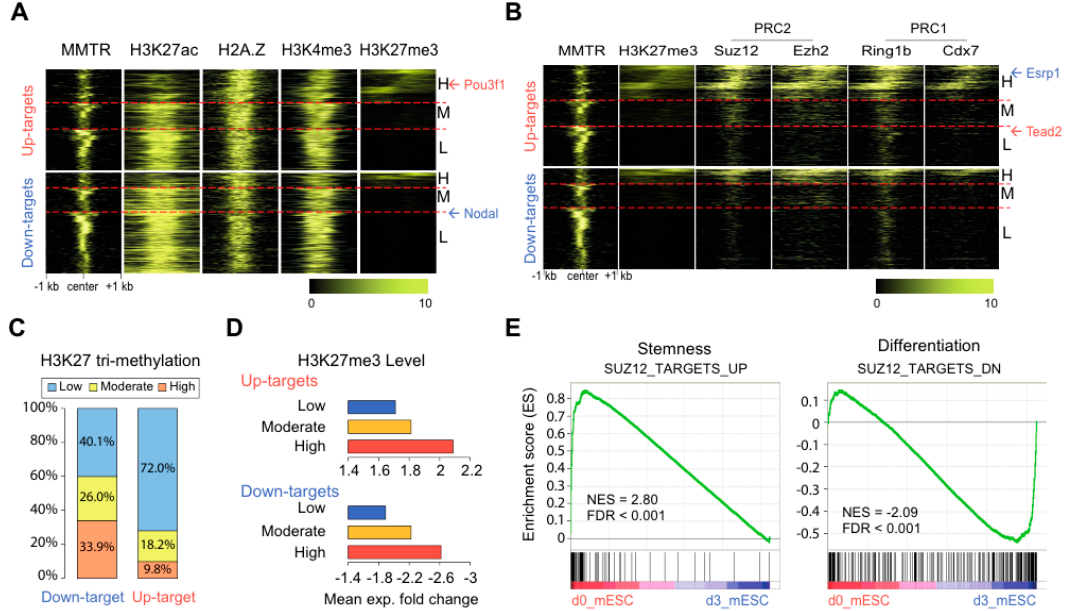
Figure 4. MMTR/Dmap1 co-localizes with PRC complex proteins at the promoters of the MMTR/Dmap1 up- and down-targets. ( A ) Heat maps showing histone modifications and H2A.Z at the MMTR/Dmap1 binding regions of up- and down-target promoters in undifferentiated mESCs. We sorted heat maps by the propensity of H3K27me3 modification (high, medium, and low levels). ( B ) Heat maps showing binding patterns of MMTR/Dmap1 and PRC proteins at the target promoters. The color bars indicate binding strength. ( C ) The proportion of H3K27me3 modification strengths in the MMTR/Dmap1 up- and down-targets. ( D ) The mean expression fold changes of both up- and down-targets during differentiation according to the strength of H3k27me3 modification. ( E ) GSEA2 analyses of MMTR/Dmap1 stemness (left) and differentiation (right) targets with differential expression by Suz12 knockout mESCs [53] . PRC, polycomb repressive complex; GSEA2, Gene Set Enrichment Analysis 2.